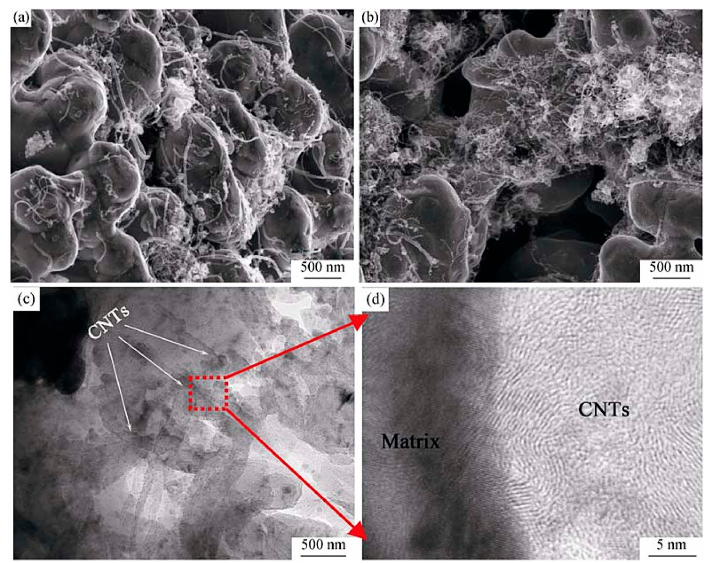
Figure 7. SEM micrographs of (W-coated CNT)-Al nanocomposites fabricated by ultrasonication method: ( a ) 5 vol % CNTs, ( b ) 10 vol % CNTs, ( c ) TEM micrograph of (W-coated 5 vol % CNT)-Al